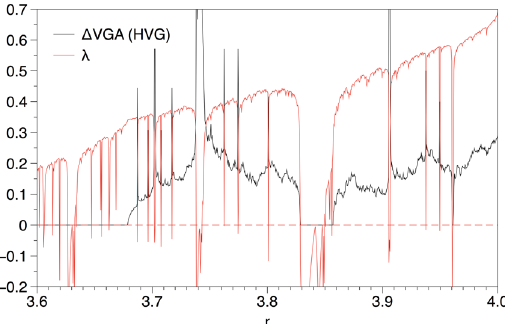
Figure 4. Plot of Δ VGA (defined as the  distance between top and bottom degree distributions) for time 1 series extracted from the logistic map x ( t + 1) = μ x ( t )[1 − x ( t )], for a range of values of μ for which the map generates chaotic trajectories of different type, interspersed by periodic windows. In the same figure we plot the Lyapunov exponent of the